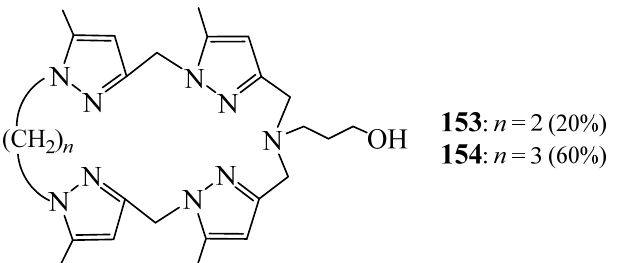
22 of 26 Figure 40. Tetrapyrazolic macrocycles 174 − 176 with functionalised lateral arms. The macrocycle with isopropyl lateral arms can also be obtained by a 2 + 2 reaction of a tripodal ligand and dibromomethane using phase transfer catalysis (PTC) in high- dilution conditions. Nevertheless, the yield of the desired macrocycle remained practi- cally unchangeable. These tetrapyrazolic macrocycles were found to be able to complex and transport across a solid membrane selectively the K + cation. Cherfi et al. [65] also conveyed the synthesis of another macrocycle with two long flexible lateral arms bearing a donor group using the same method reported by Malek et al. [64]. They found that the ability of this macrocycle to extra selectively K + is improved with the increasing the lateral arm length. As a continuation of these studies, Harit et al. [66,67] synthesised a new generation of bi-functionalised tetrapyrazolic macrocycles 150 − 152 by reaction of 1,4- bis(3 ′ -chloro- methyl-5 ′ -methyl-l’-pyrazolyl) butane with primary amines with the aim to increase the cavity size of these compounds (Figure 41). Indeed, the resulting compound was found to be complex and also transport selectively the Cs + cation. Figure 41. Other tetrapyrazolic macrocycles 150 − 152 with two sidearms. They also elaborated a new generation of this kind of macrocycles using the same method and changing the bis-chlorinated derivative (n = 1) by its brominated homologue to improve the cyclisation reaction yield. However, no particular change was obtained [68]. Besides their ability to complex selectively K + , they possessed some antibacterial ac- tivity (32 μ g/mL) against both Gram-positive and Gram-negative bacteria. Other homo- logues of macrocycles reported by Bol et al. [63] were also synthesised. They also showed an affinity to complex K + cation and some antibacterial activity [69].